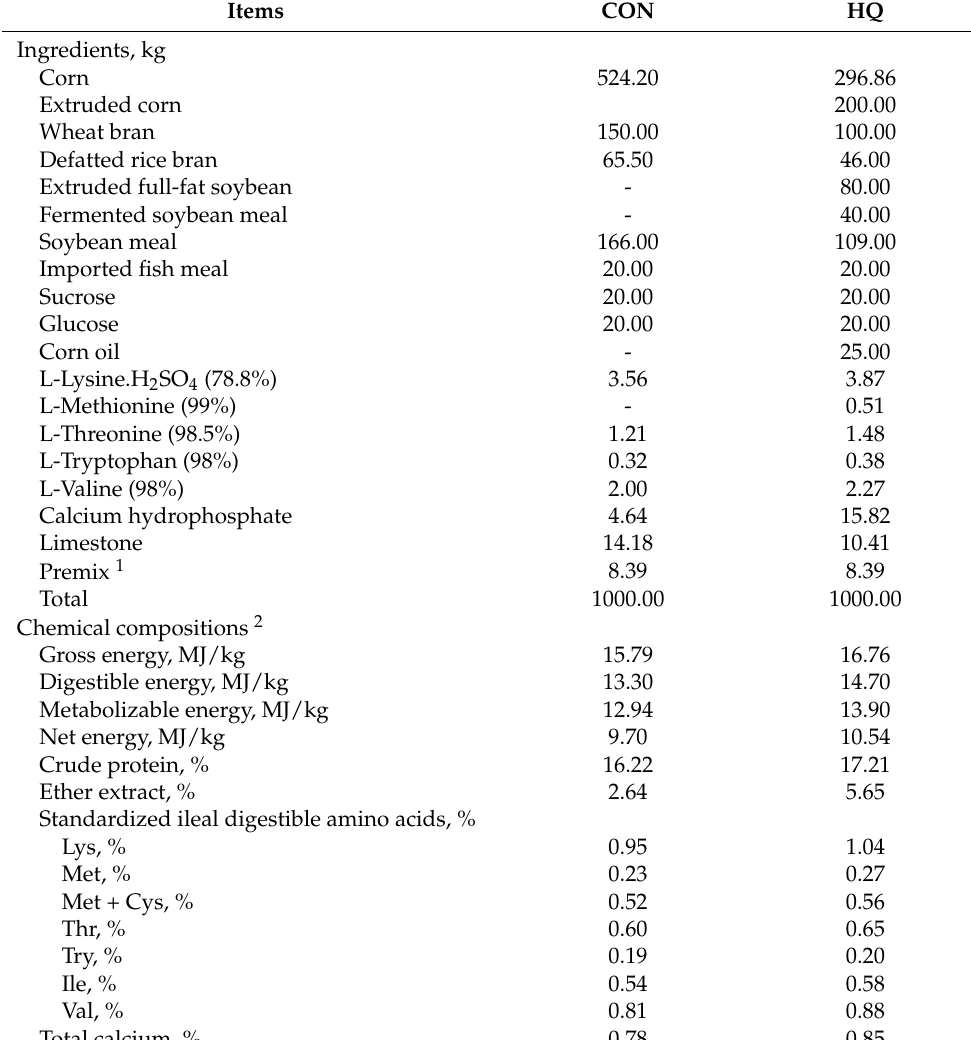
Table 1. Diet composition and nutrient levels (fed